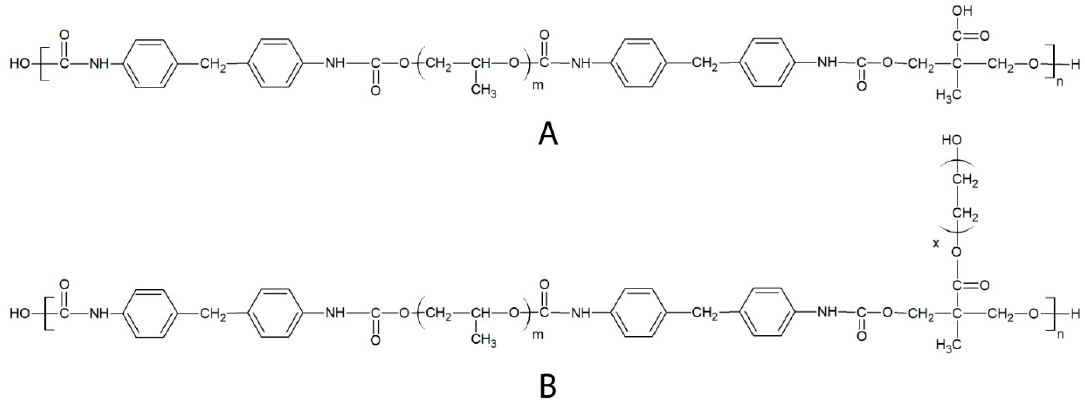
Figure 1. Chemical structure of the repeat unit of PEUA ( A ) and PEUA-PEG ( B ).